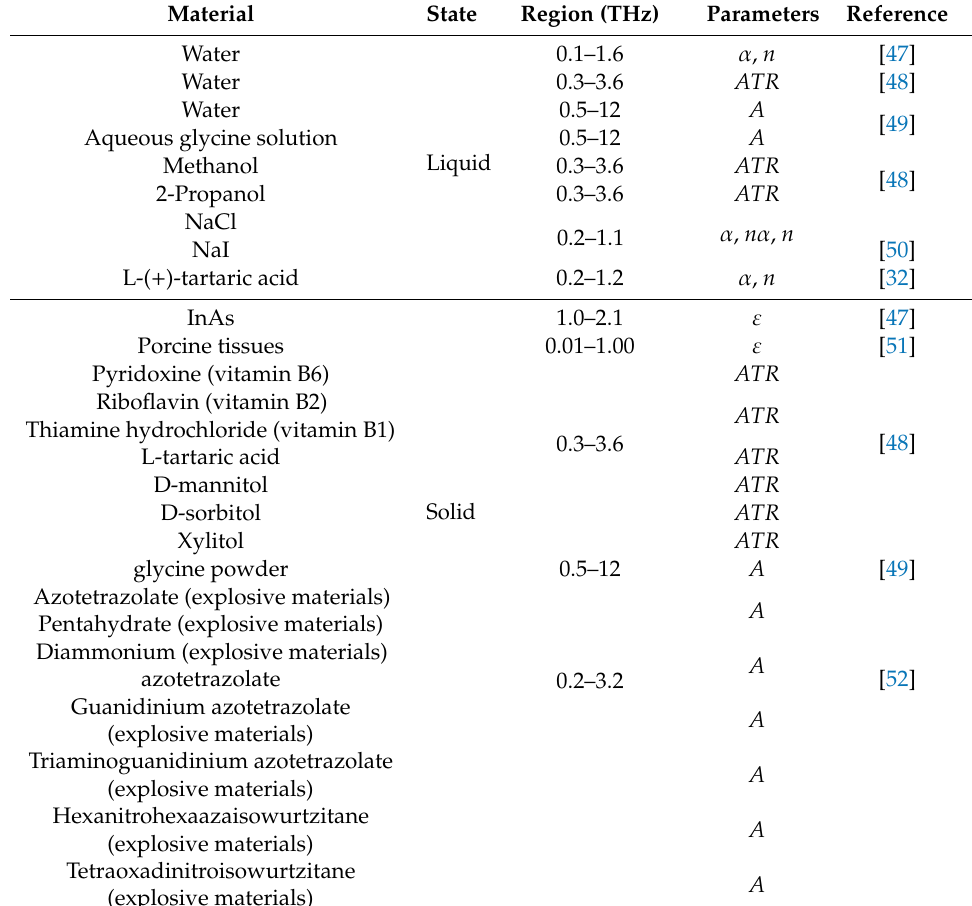
Table1. TheopticalanddielectriccharacteristicsofcertainsubstanceobtainedbyTHz-ATRspectroscopy reported in the